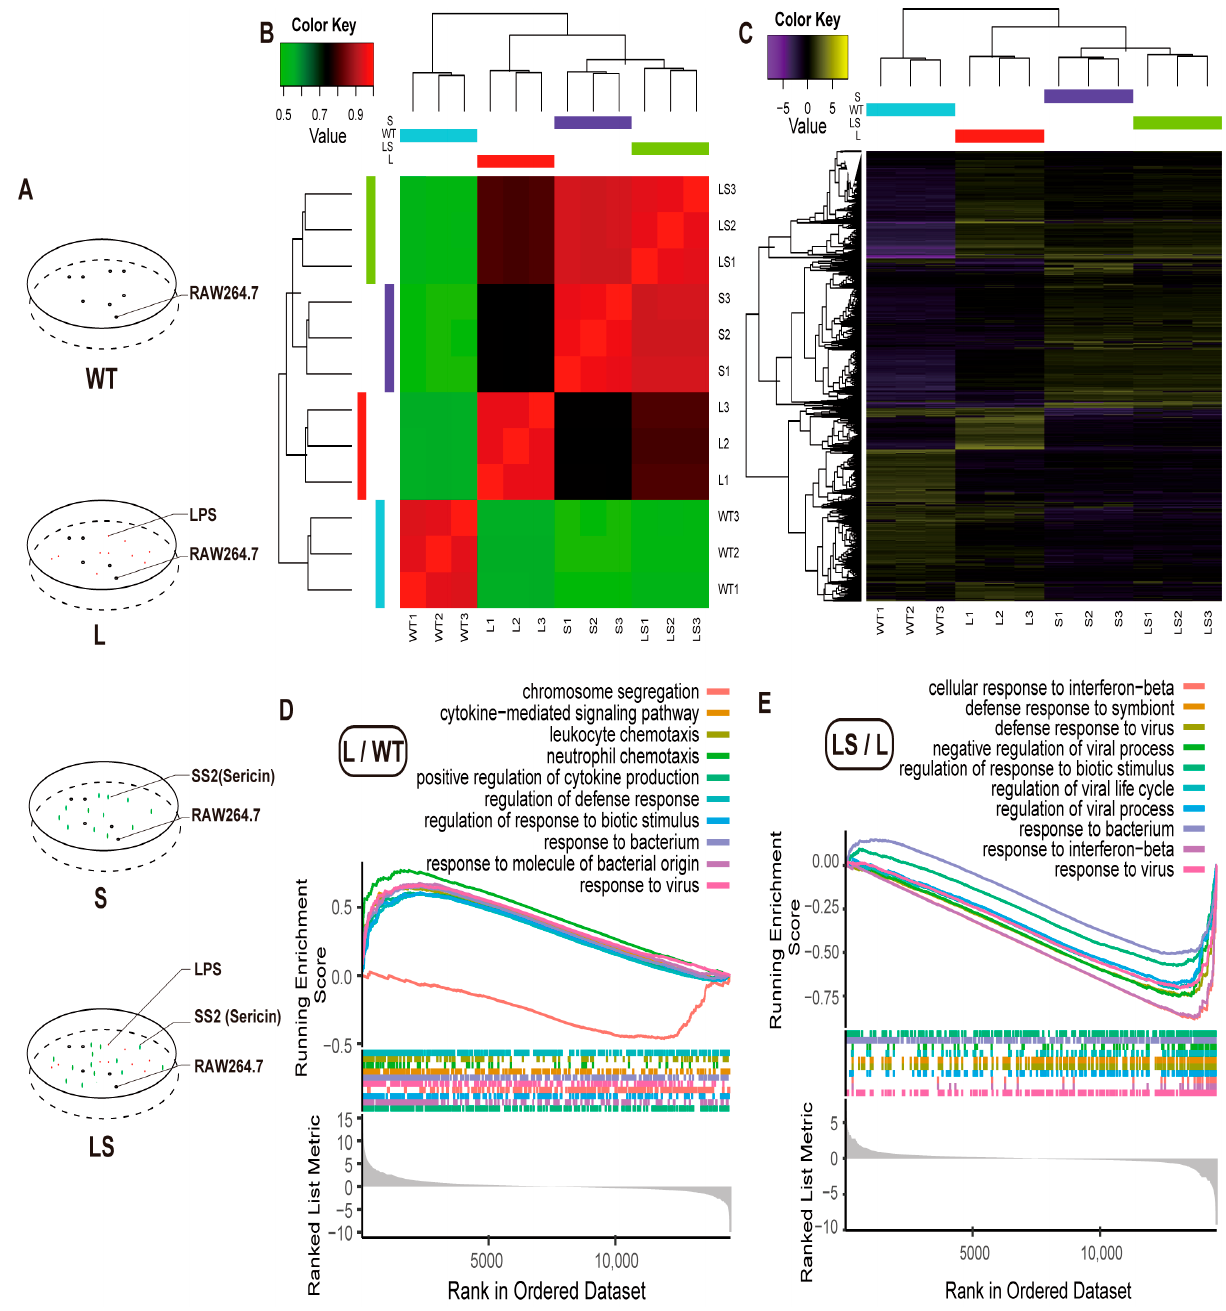
Figure 4. GO analysis. ( A ) Experimental design. ( B ) Heatmap of sample correlation analysis. ( C ) Heatmap of differential gene expression. ( D , E ) Gene Ontology (GO) annotation of the DEGs of L/WT ( D ) and LS/L ( E ).